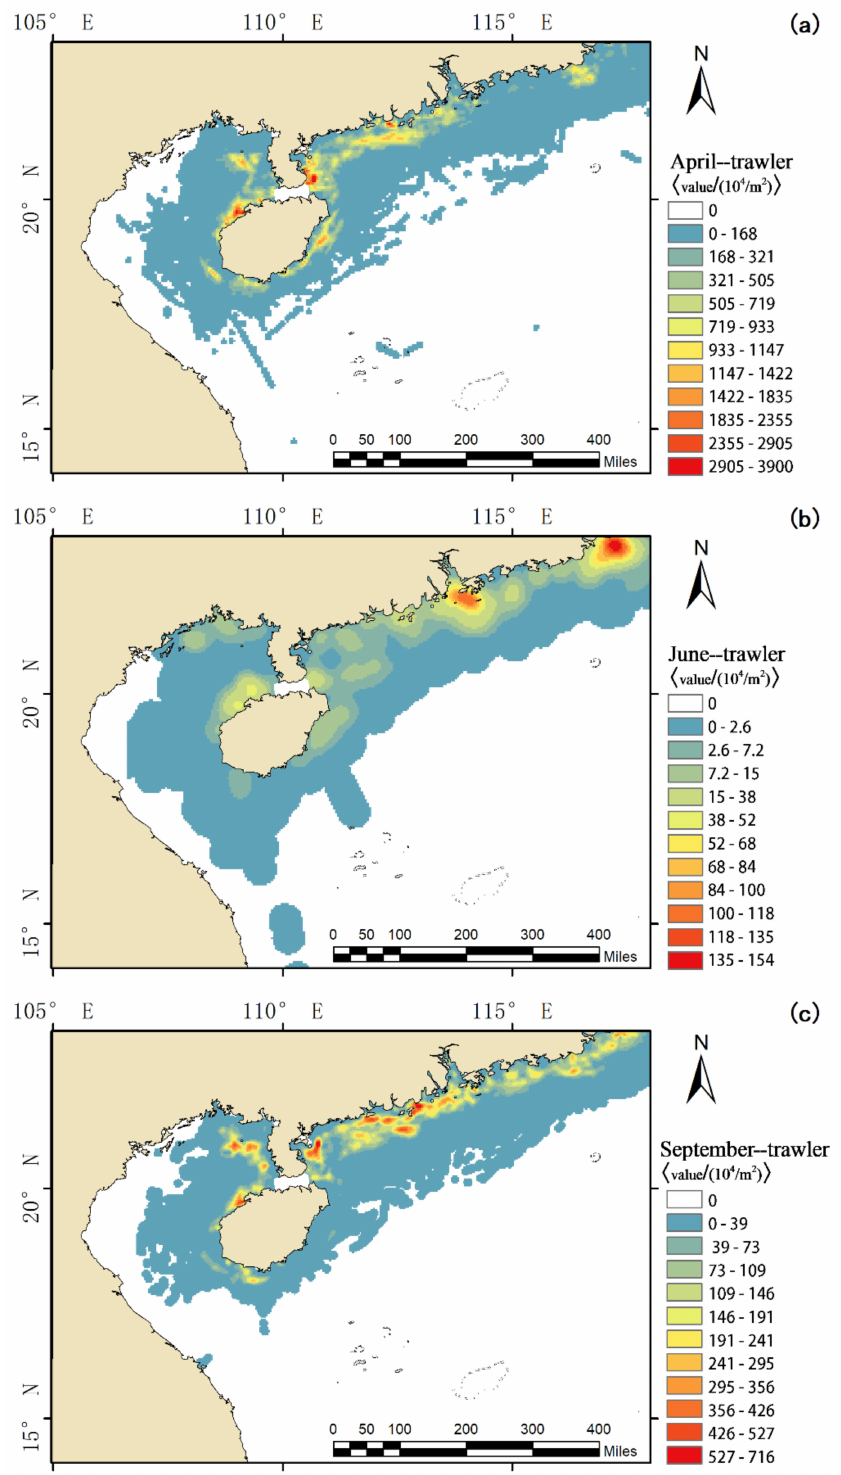
Figure 14. Nuclear density analysis chart of Chinese trawlers in April ( a ), June ( b ) and September ( c